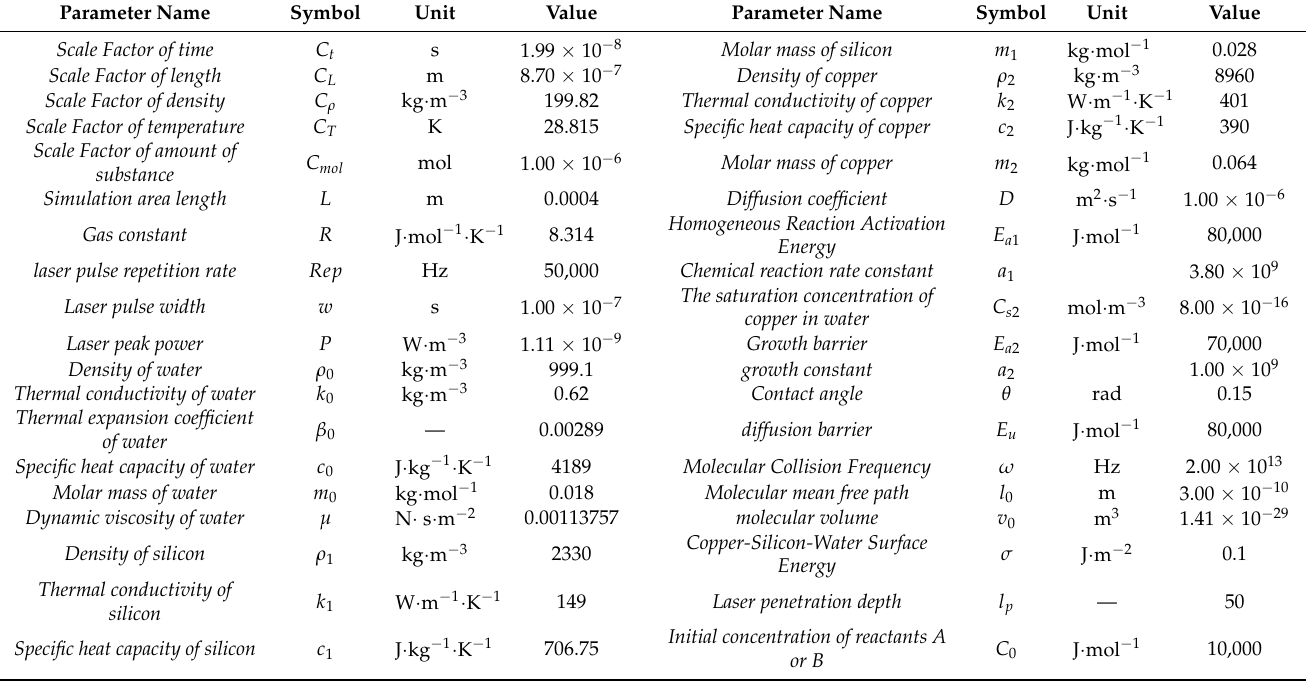
Table 2. Physical and Chemical Parameters.